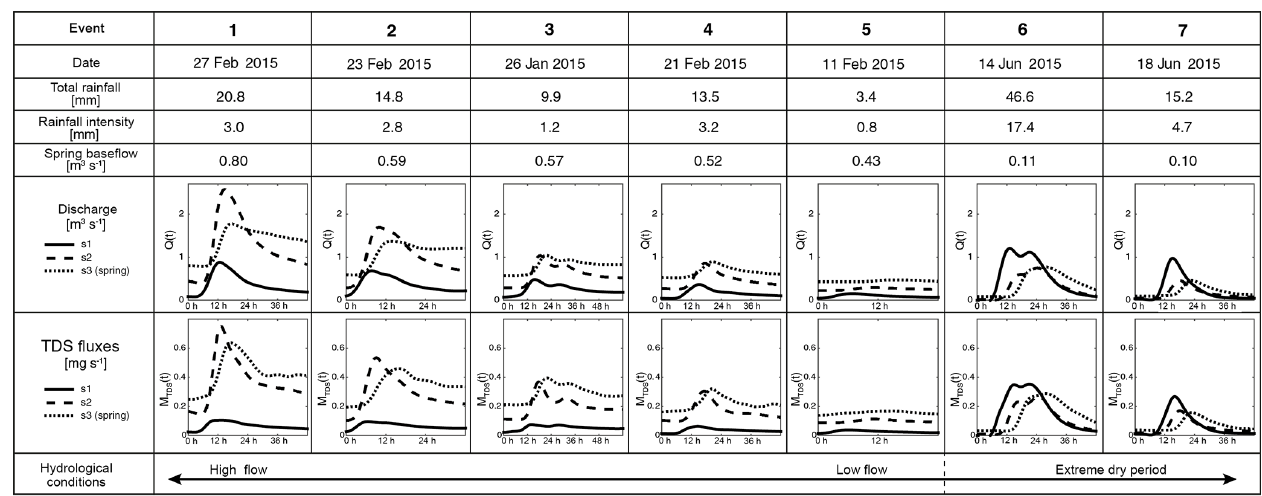
Figure 4. Summary of the flood event selection sorted as a function of spring baseflow